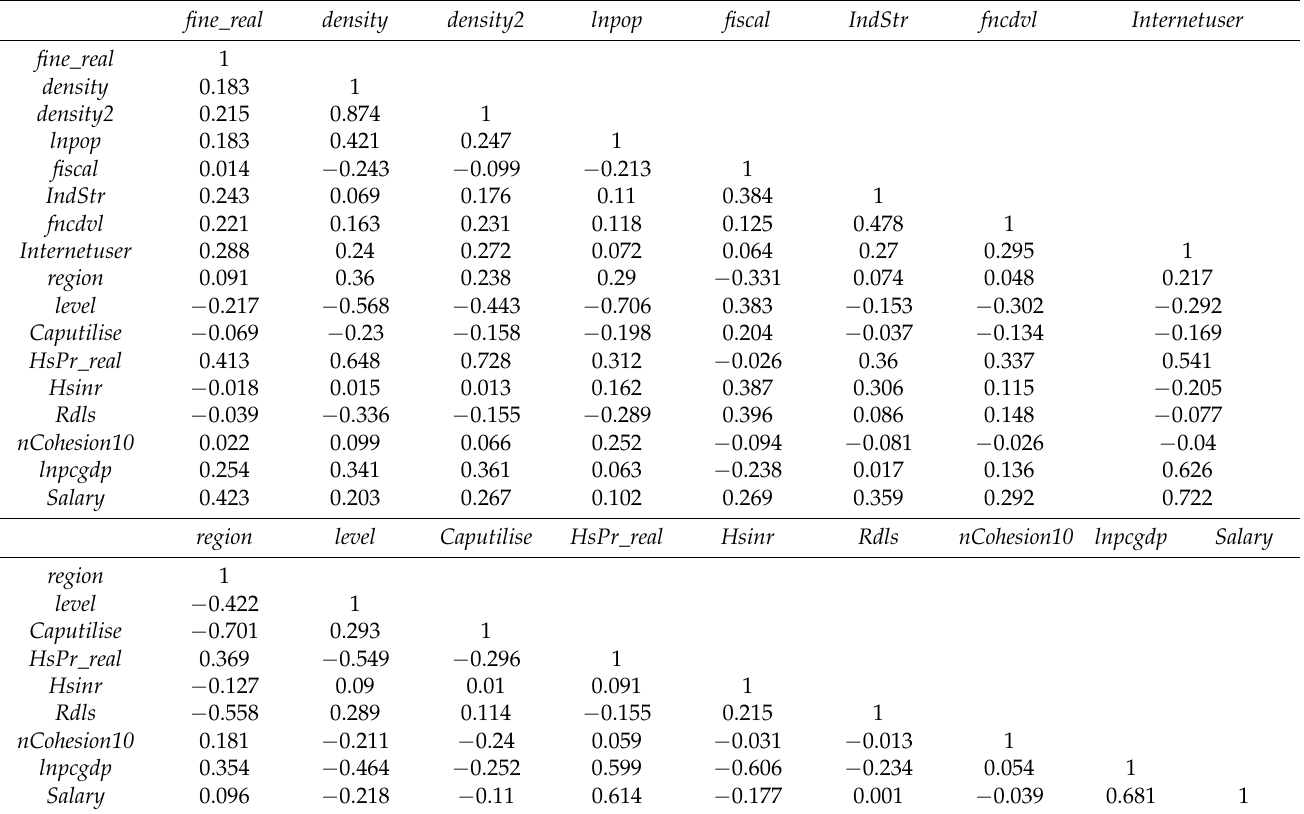
Table 2. Correlation coefficient